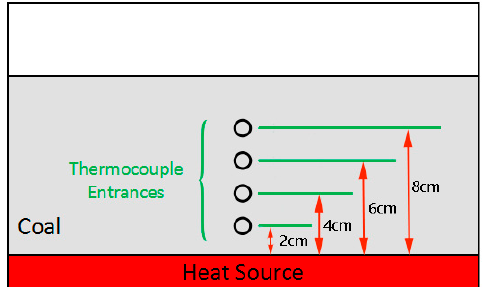
Figure 3. The indirect thin-layer plane drying device with thermocouple insertion positions.